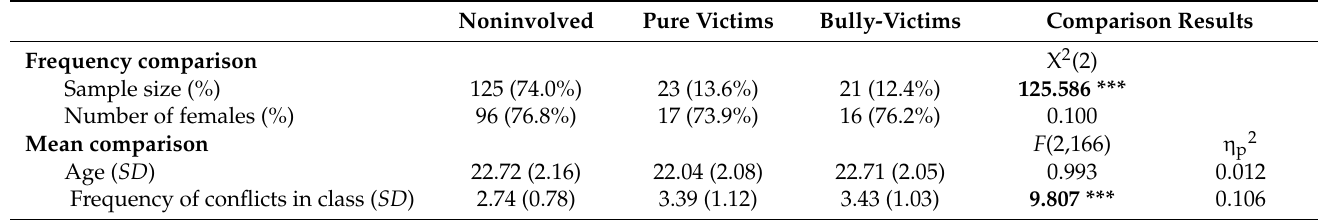
Table 4. Demographic Description of the Person-Oriented Bullying-Related